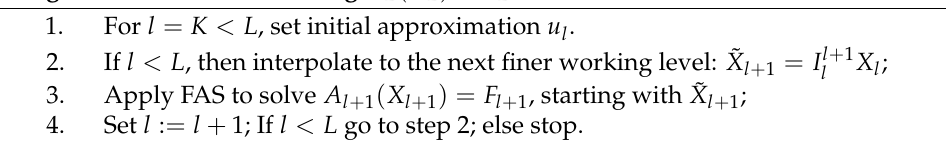
Algorithm 2: FMG for solving A L ( X L ) = F L